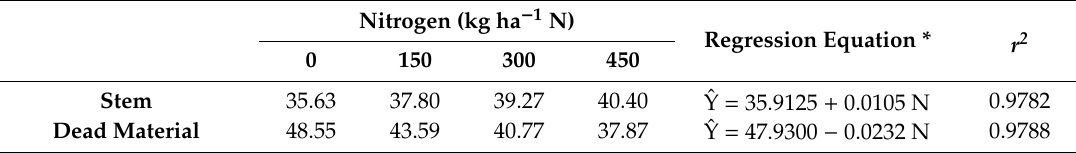
Table 11. Percentage averages of stem and dead material in post-grazing forage mass of